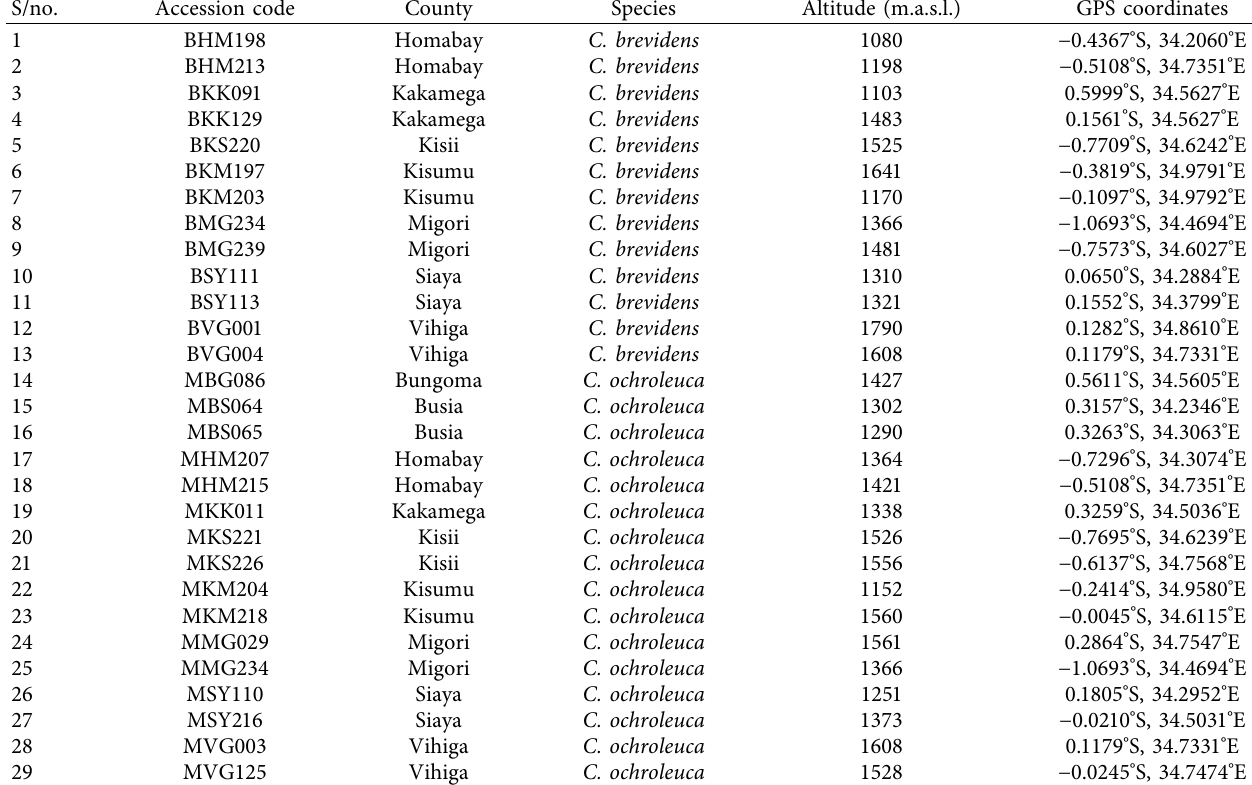
Table 1: Twenty-nine slender leaf accessions collected from nine counties in Kenya. S/no.